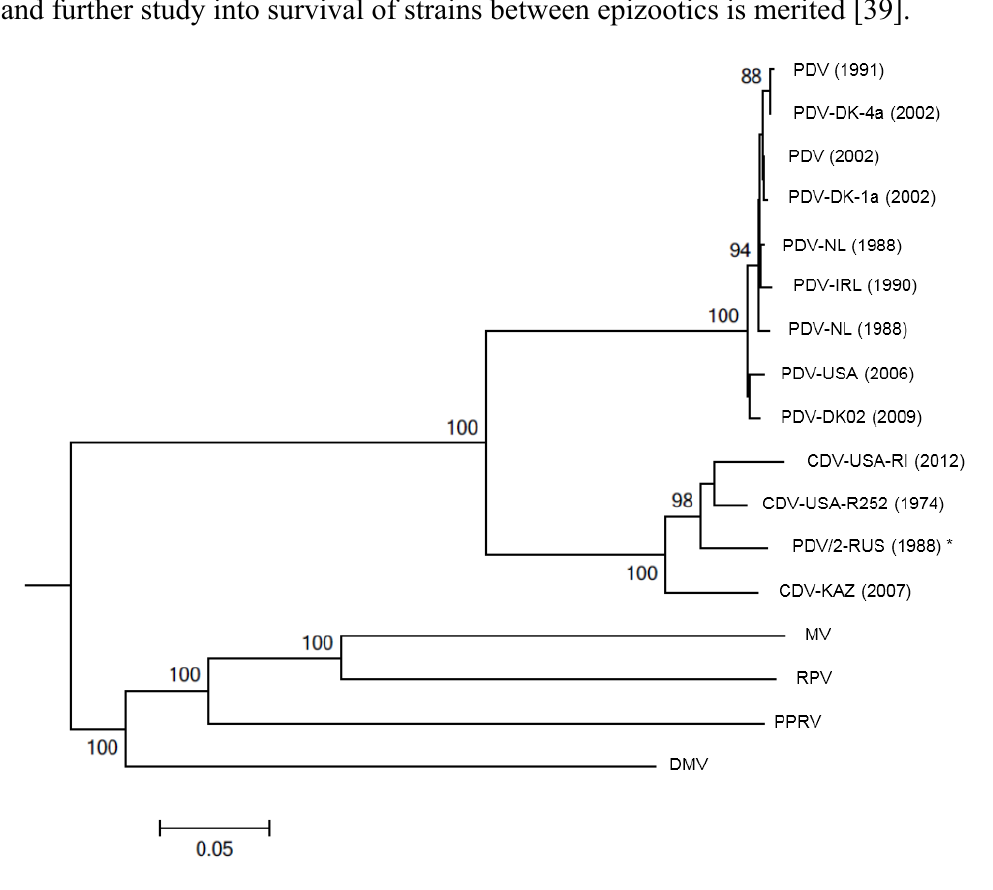
Figure 1. Evolutionary relationships of phocine distemper virus (PDV) isolates to the other morbilliviruses. The neighbor-joining method [46] was used to generate a phylogenetic tree based on the hemagglutinin (H) glycoprotein sequences of seventeen selected PDV, CDV, MV, RPV, PPRV and DMV strains (branch length 1.59). Positions containing gaps were eliminated. Bootstrap analysis [47] was used to indicate the percentage number of trees from 1000 replicates in which the virus H glycoprotein sequences clustered equivalently.